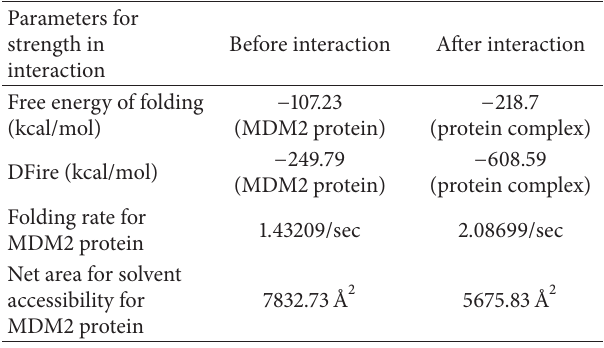
Table 4: Analysis for the strength in the interaction of MDM2 pro- tein after interaction with DHFR protein/MDM2-DHFR